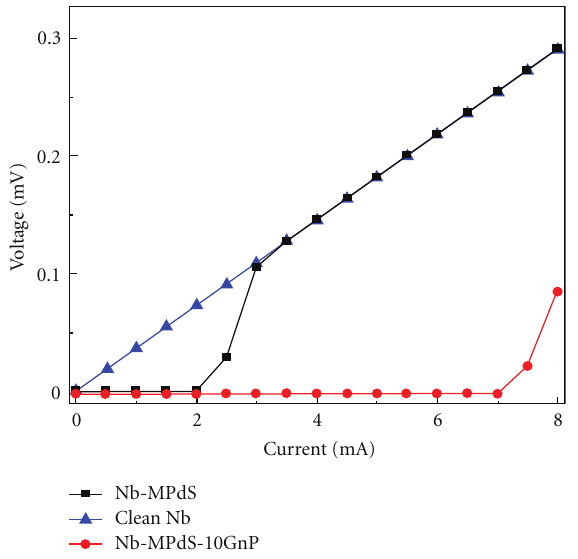
Figure 5: V-I characteristics of 150 nm Nb superconductor film at 8K, just below the critical temperature for superconductor transition. The black line presents data corresponding to clean Nb film, where the critical current (onset of voltage drop) is around 2mA. The blue line was measured on the same Nb film after MPdS adsorption, showing that the critical current is suppressed. The red line presents the situation after 10nm dia. gold NPs were deposited onto the MPdS, significantly enhancing the critical current to around